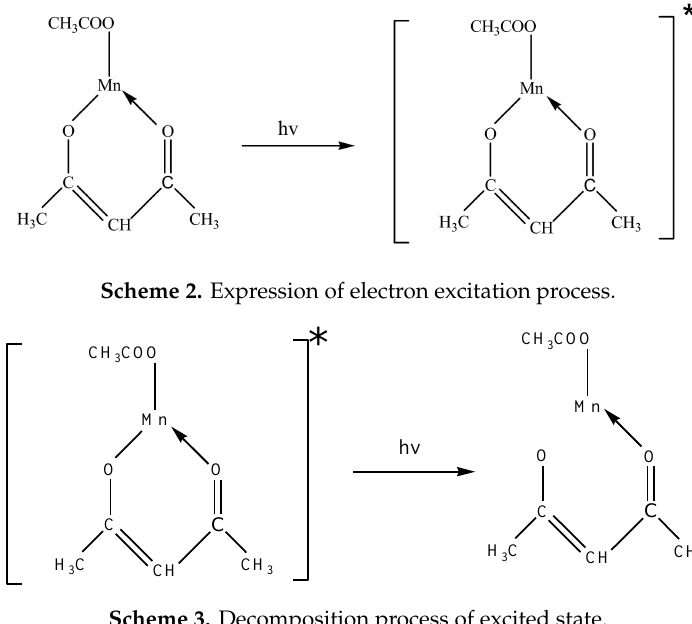
Figure 3. UV-Vis absorption spectra of the CaMn 7 O 12 gel film at different UV irradiation times.